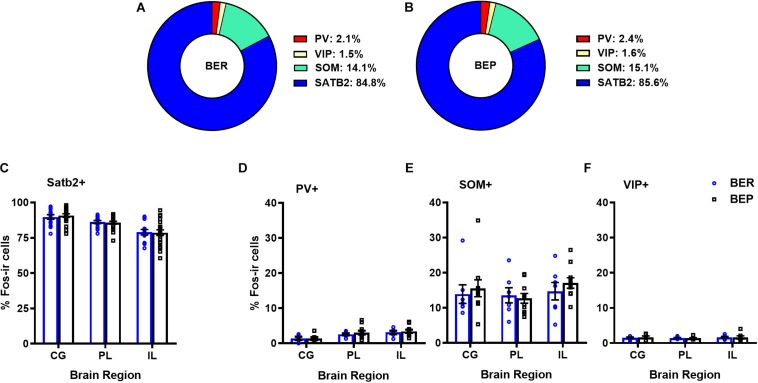
Proportions of mPFC excitatory and inhibitory neurons that express Fos during PF exposure in BEP and BER rats. Pie charts in (A) and (B) represent mean proportions (averaged across each mPFC sub-region) of all Fos+ neurons co-localized with excitatory and inhibitory neuron markers in BERs and BEPs. Bottom panel displays the proportions of Fos+ neurons, separated by mPFC sub-region, co-localized with excitatory neuron marker Satb2 (C) or inhibitory neuron markers PV (D), SOM (E), and VIP (F). Error bars represent 1 SEM.